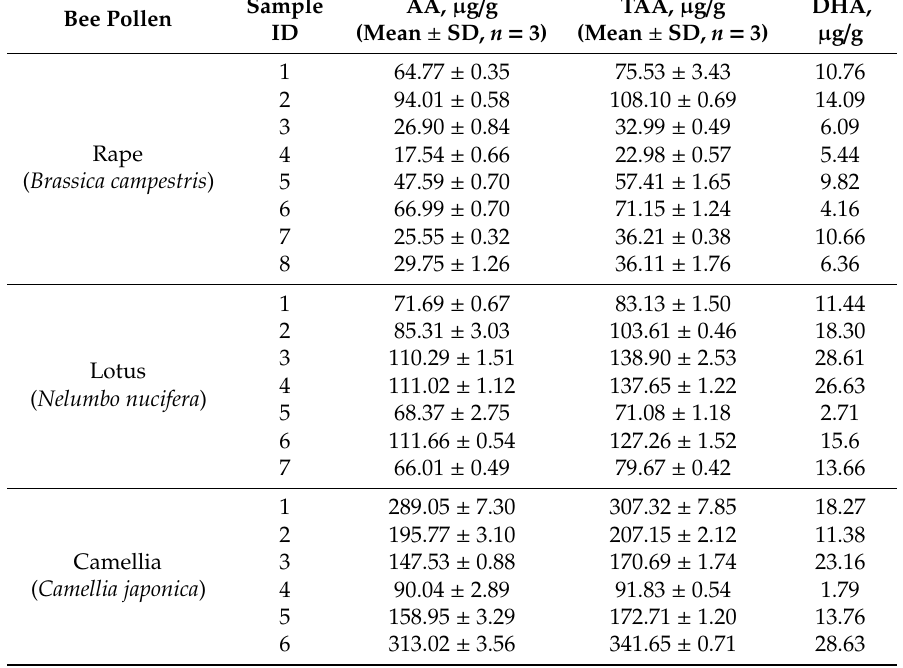
Table 2. The AA, total ascorbic acids (TAA), and DHA contents in the investigated bee pollen